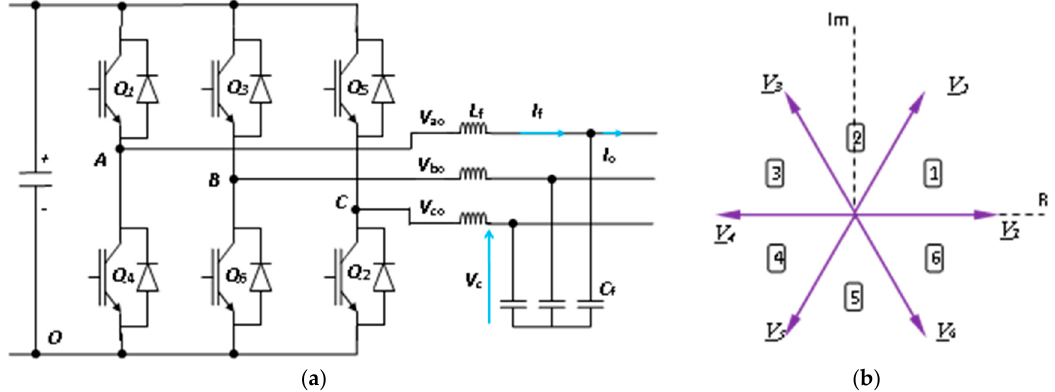
Figure 4. ( a ) The power circuit diagram of a 3- ϕ inverter. ( b ) The 3- ϕ inverter space vectors.